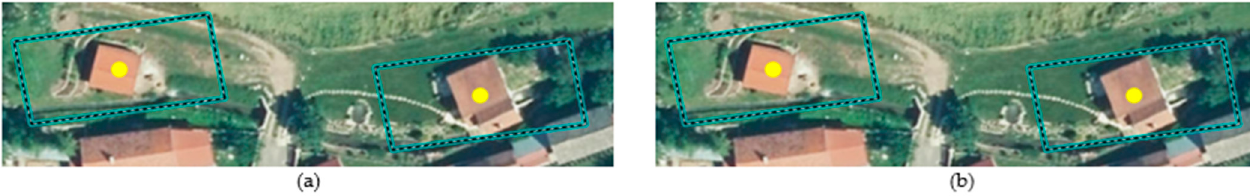
Figure 12. Example of the verification process based on data from the dataset Sentinel-2 L2A—True color: ( a ) 2017 dataset on the orthophoto base map 2018; ( b ) 2018 dataset on the orthophoto base map 2018.